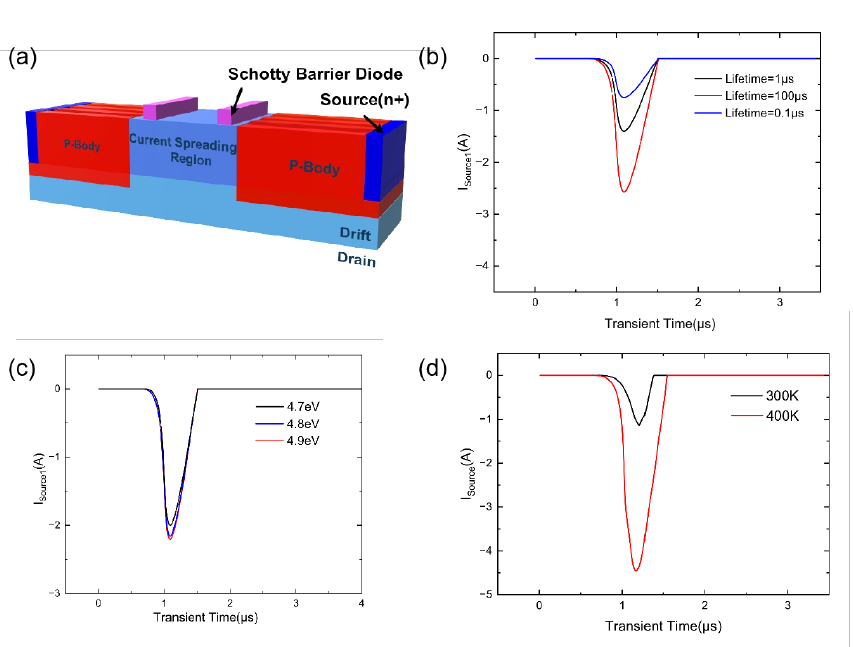
Figure 8. ( a ) Schematic view of two crosswise SBD structures. Recovery characteristics with different ( b ) lifetimes, ( c ) work functions, and ( d )